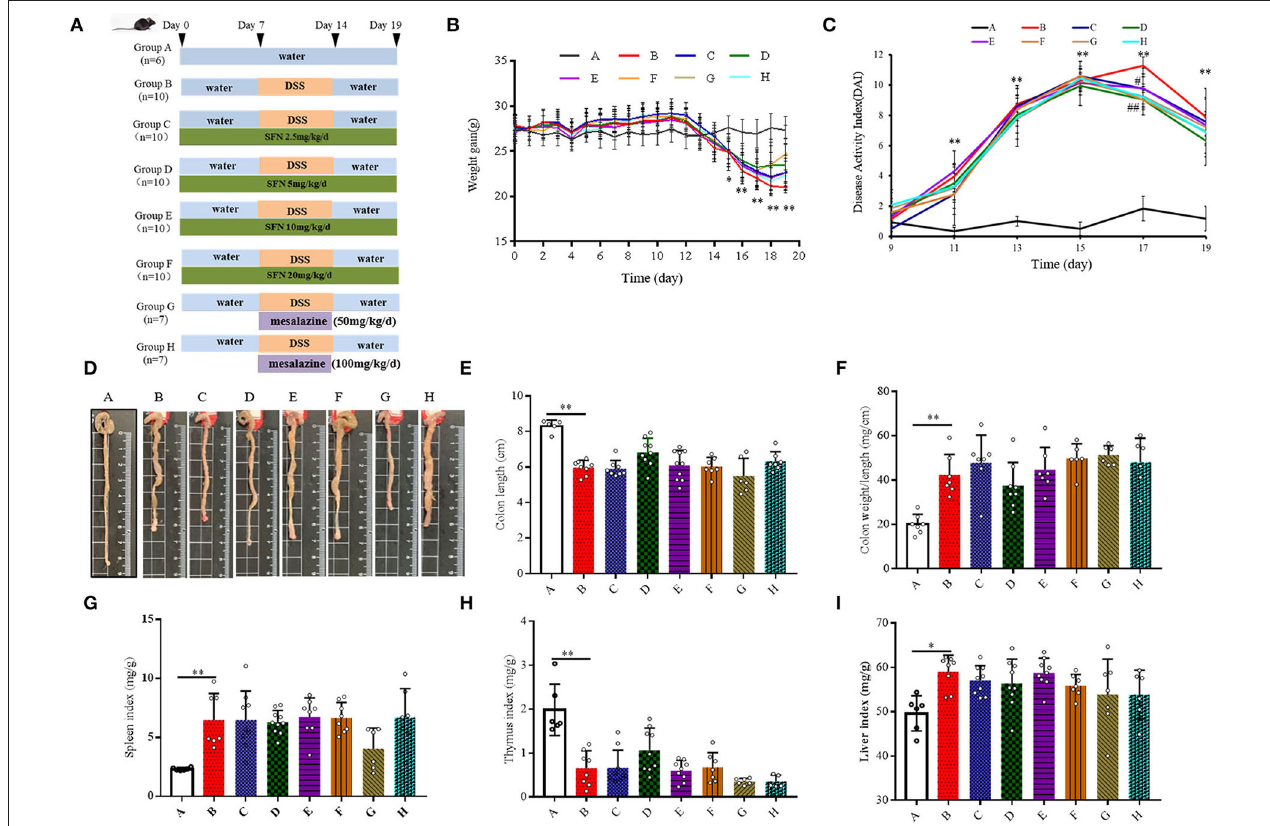
FIGURE 1 | Effect of SFN on colitis symptoms in mice. (A) Scheme of the animal experimental design. Group A: Negative control; Group B: Colitis model (2% DSS in drinking water); Group C: SFN (2.5 mg/kg/d) + colitis model (2% DSS in drinking water); Group D: SFN (5 mg/kg/day) + colitis model (2% DSS in drinking water); Group E: SFN (10 mg/kg/day) + colitis model (2% DSS in drinking water); Group F: SFN (20 mg/kg/day) + colitis model (2% DSS in drinking water); Group G: Mesalazine (50 mg/kg/day) + colitis model (2% DSS in drinking water); Group H: Mesalazine (100 mg/kg/day) + colitis model (2% DSS in drinking water). (B) Mean body weight over time. (C) DAI score. (D) Representative macroscopic pictures of colons in each group. (E) Colon length. (F) Colon weight/ length ratio. (G) Spleen index. (H) Thymus index. (I) Liver index. All data are presented as the mean ± SD. P value < 0.05 was considered to indicate statistical significance (* P < 0.05 and ** P < 0.01 compared with Group A, # P < 0.05 and ## P < 0.01 compared with Group